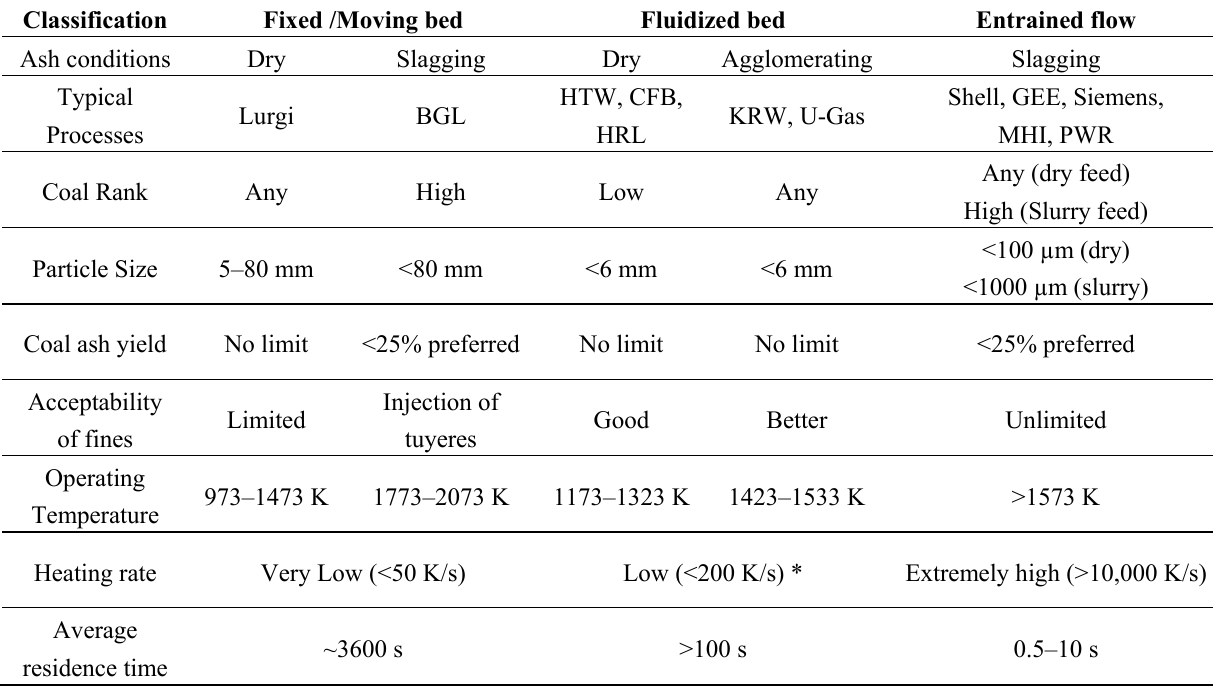
Table 1. Operating parameters of different groups of gasifiers